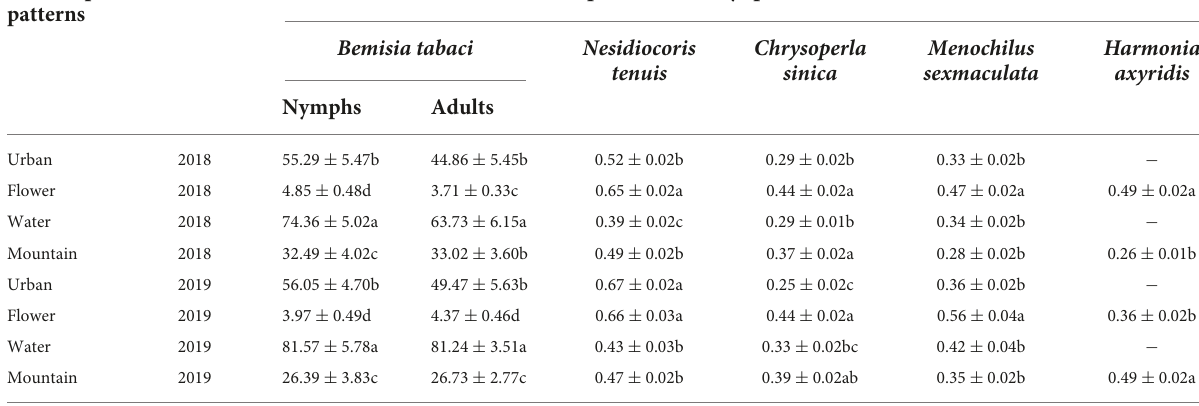
TABLE 5 Population density of Bemisia tabaci and its dominant predators during the main activity period on summer tomato fields in four different agricultural landscapes. Landscape